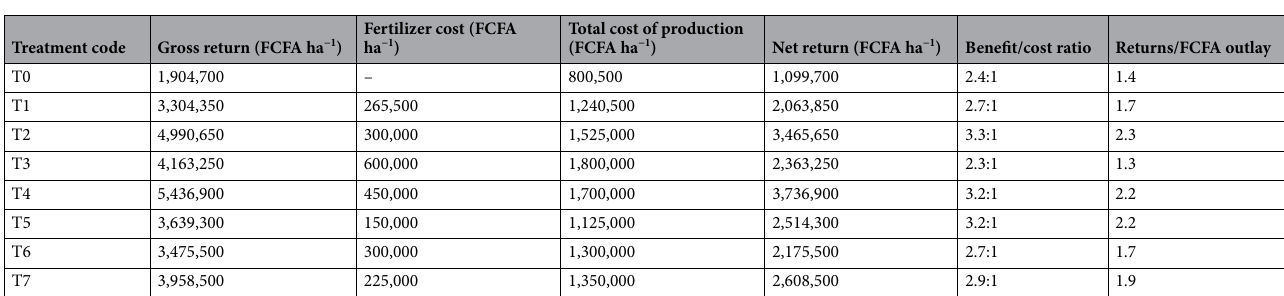
Table 5. Economics of producing cassava under each treatment for cropping seasons 2016/2017–2017/2018. Notes: T0 = control (no amendement), T1 = IF : 13-13-23 NPK at 450 t ha −1 + urea at 100 t ha −1 , T2 = TB at